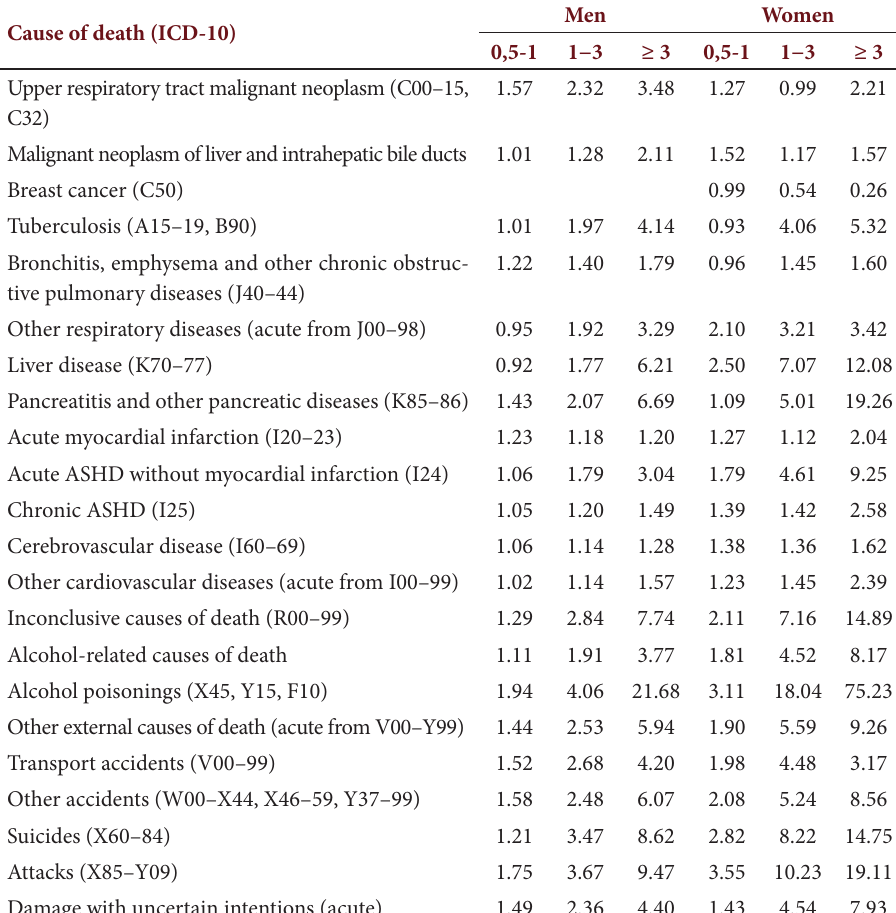
Table 1. Relative risks of death for men aged 15 to 74 from various causes depending on the type of alcohol consumption (measured as pure alcohol equivalent per week) Cause of death (ICD-10)